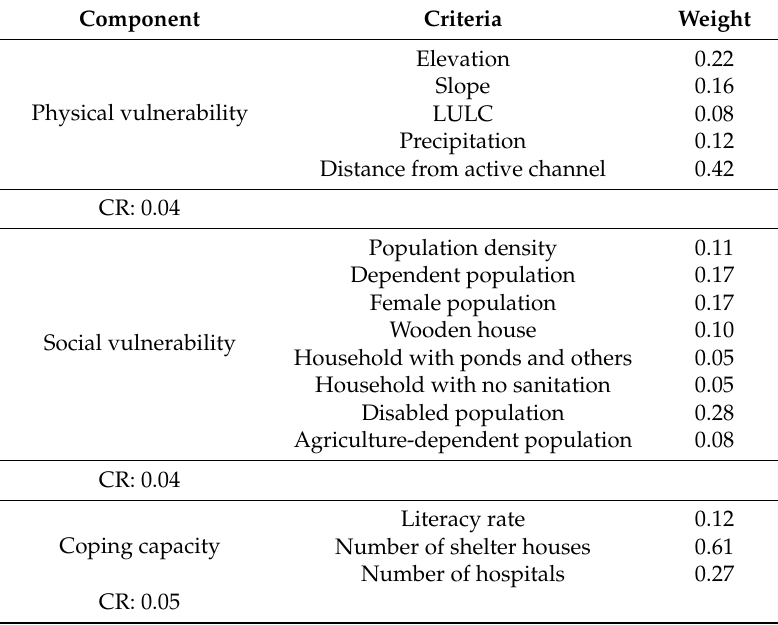
Table 4. Weighting the criteria using